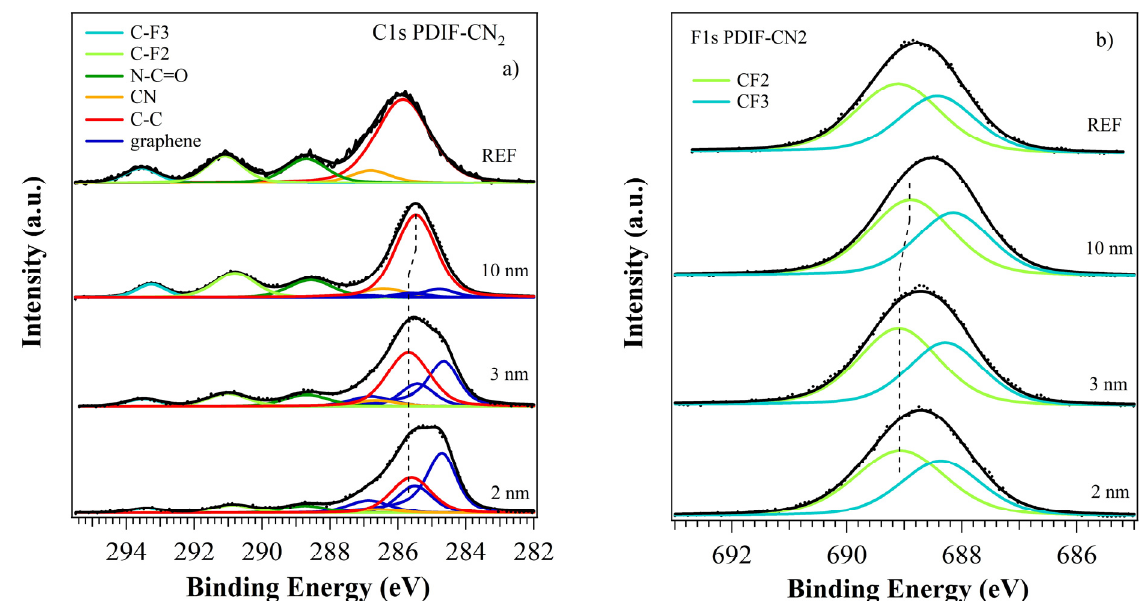
Figure 3. XPS analysis of the C1s ( a ) and F1s ( b ) core levels of the PDIF-CN2 film deposited on graphene, at different thicknesses. The spectra for the thick films are shown on the top for reference. The vertical lines suggest the BE shift for the main C1s and F1s molecular components for the 10 nm film.